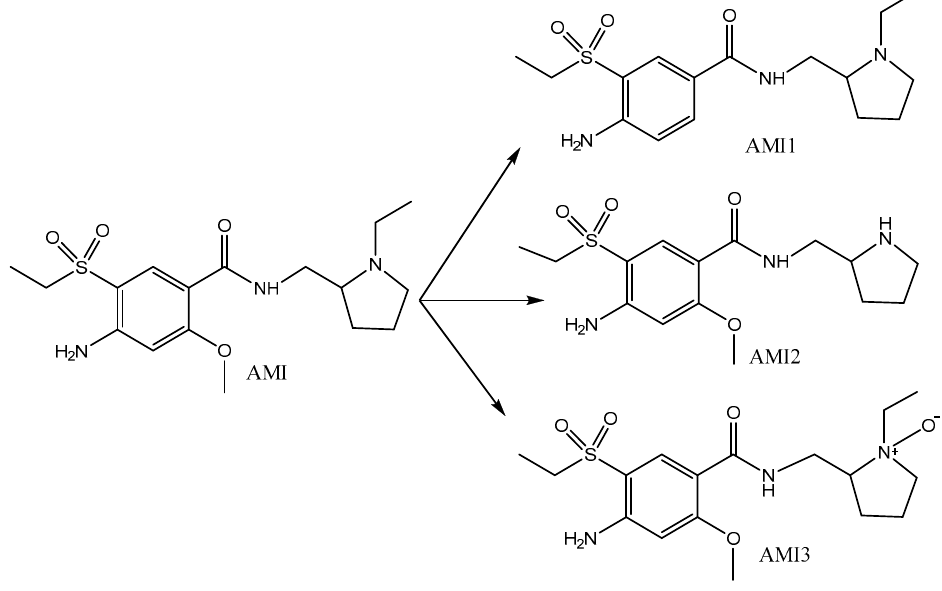
Figure 4. Photocatalytic degradation pathways of amisulpride.